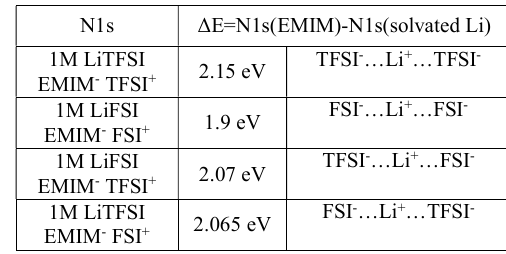
Table 2. Calculated ΔE=N1s (EMIM) -N1s (solvated Li) for